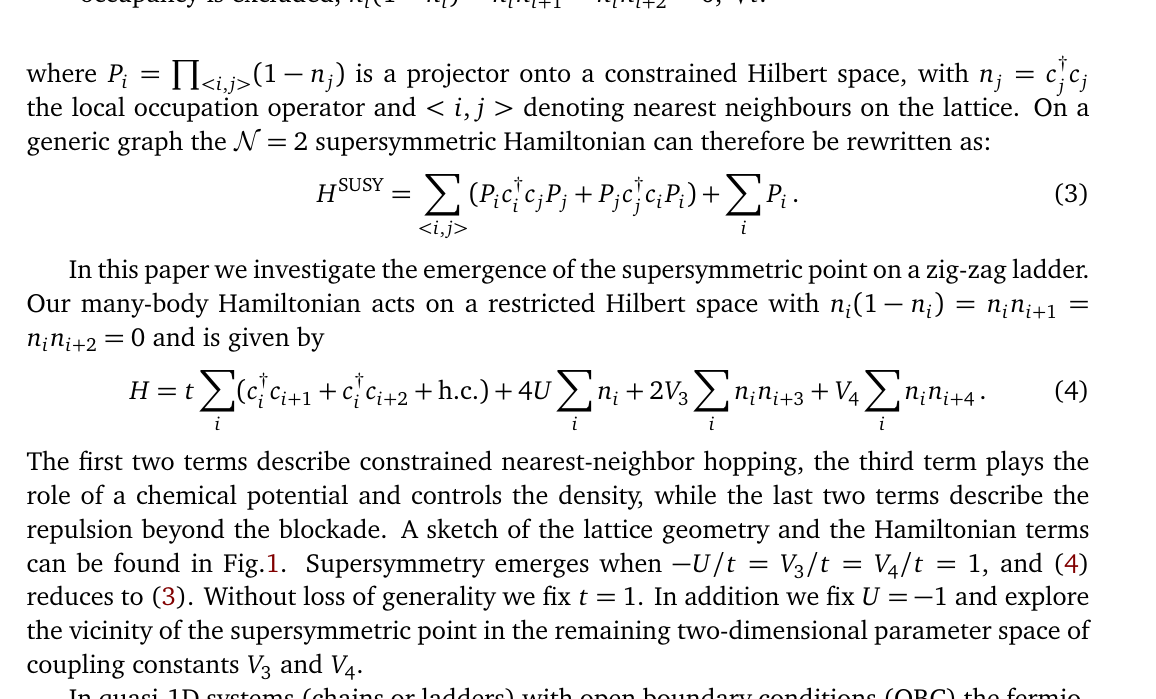
, V are highlighted as solid blue and dashed red lines 3 4 ( 1 − n ) = n = n = 0, ∀ i n n i i i i + 1 i i + 2